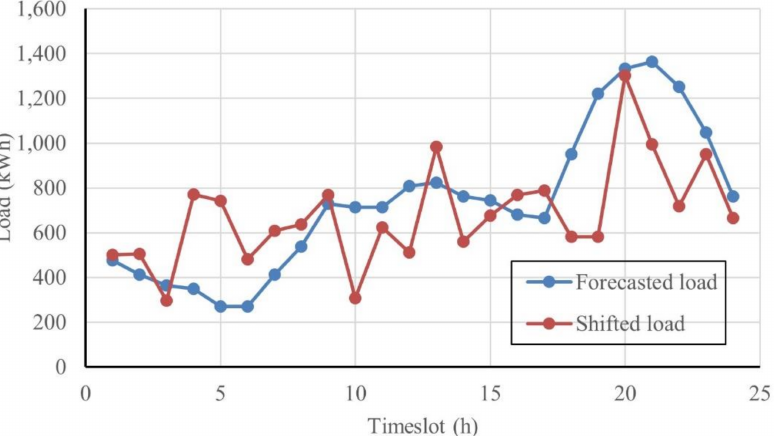
Figure 11. Hourly residential load before and after DSM using the distributed algorithm